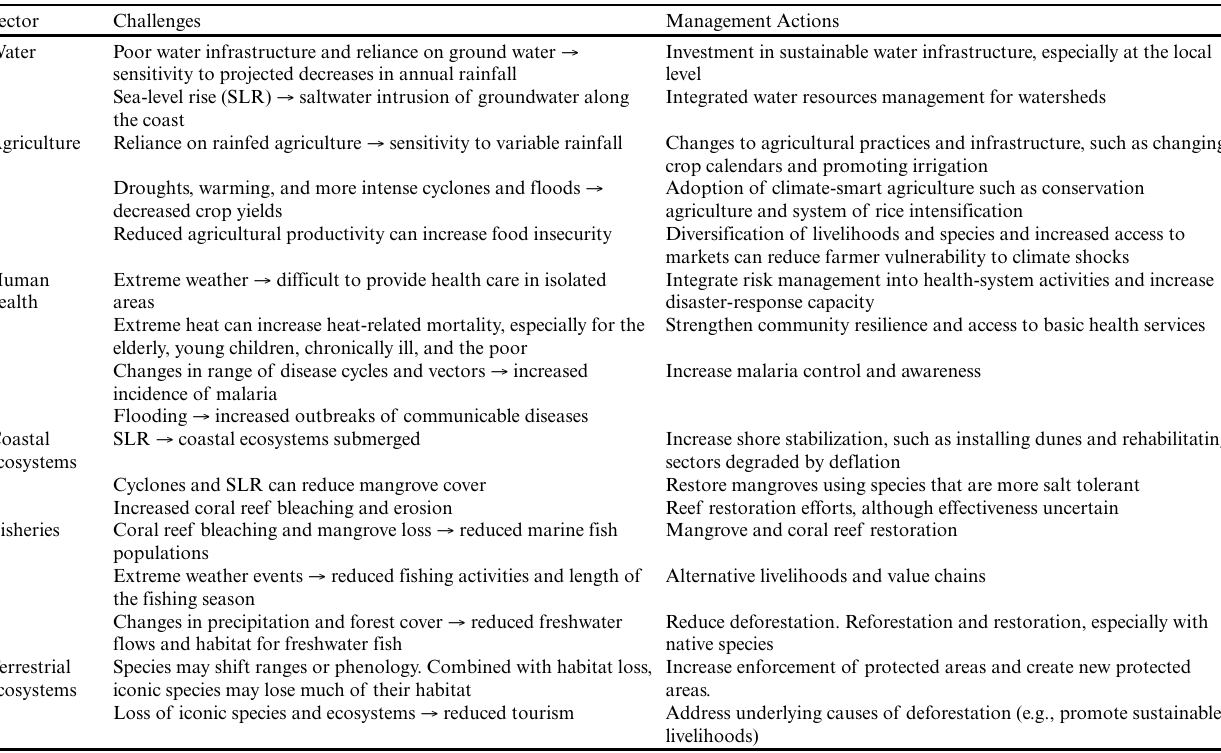
Table 1 . List of climate change challenges and possible management actions to address them for multiple sectors in